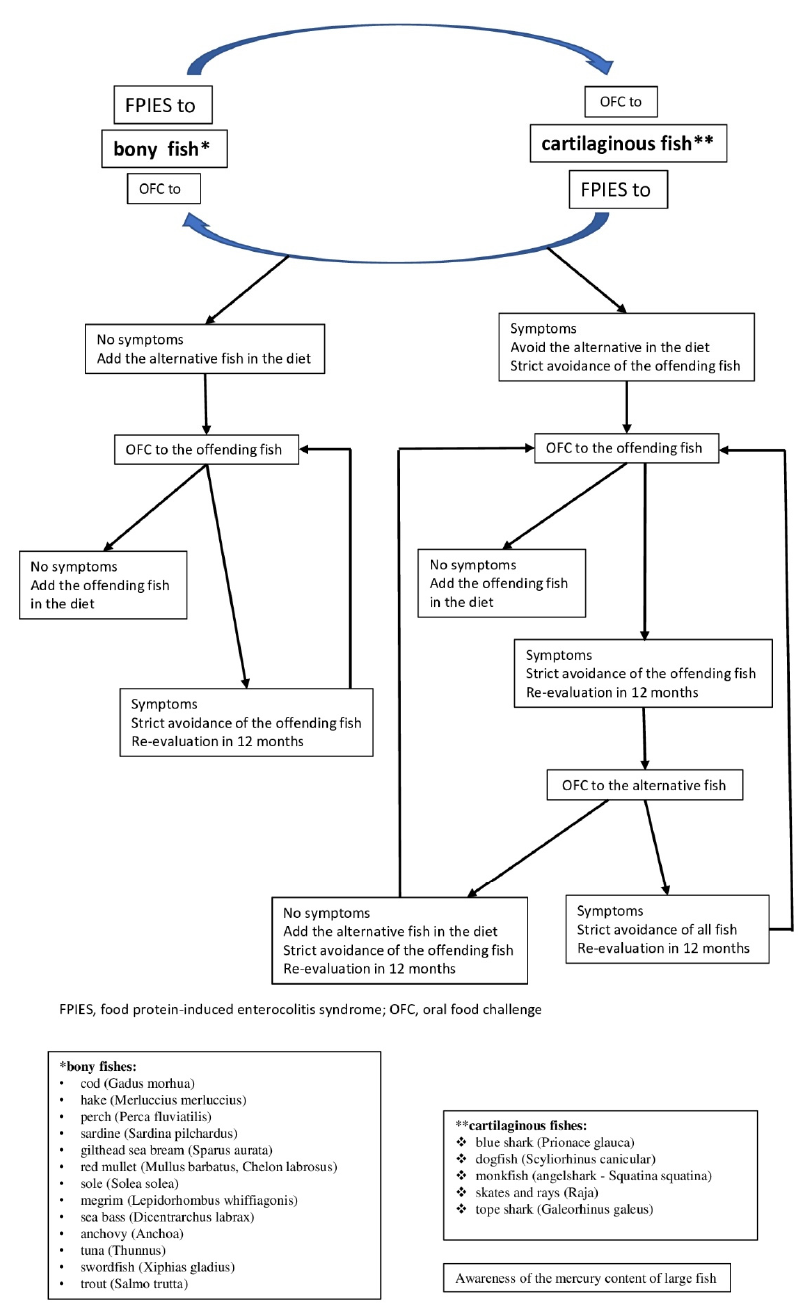
Figure 1. Algorithm for the management of food protein-induced enterocolitis syndrome (FPIES) caused by fish. * bony fishes: cod ( Gadus morhua ), hake ( Merluccius merluccius ), perch ( Perca fluviatilis ), sardine ( Sardina pilchardus ), gilthead sea bream ( Sparus aurata ), red mullet ( Mullus barbatus , Chelon labrosus ), sole ( Solea solea ), megrim ( Lepidorhombus whiffiagonis ), sea bass ( Dicentrarchus labrax ), anchovy ( Anchoa ), tuna ( Thunnus ), swordfish ( Xiphias gladius ), trout ( Salmo trutta ); ** cartilaginous fishes: blue shark ( Prionace glauca ), dogfish ( Scyliorhinus canicular ), monkfish (angelshark— Squatina squatina ), skates and rays ( Raja ), tope shark ( Galeorhinus galeus ) (Information on fish species identification from www.fishbase.org (accessed on 1 November 2021)